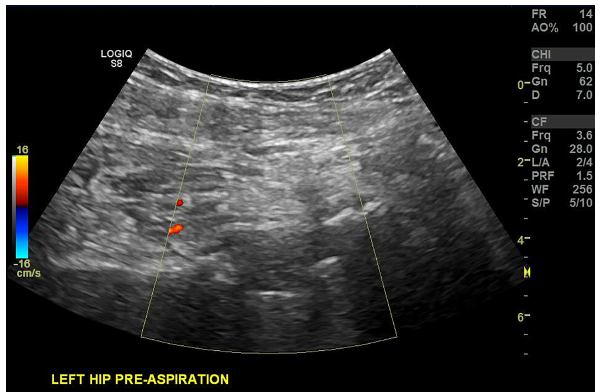
Figure 4. Ultrasound image of hip arthroplasty with color Doppler for identification of the circumflex